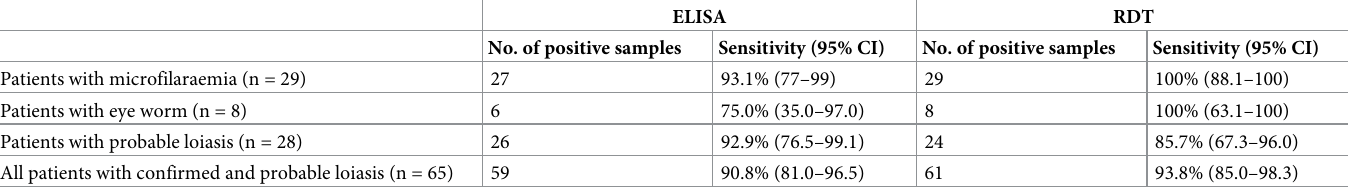
Table 1. Sensitivity of the RDT and ELISA test by infection